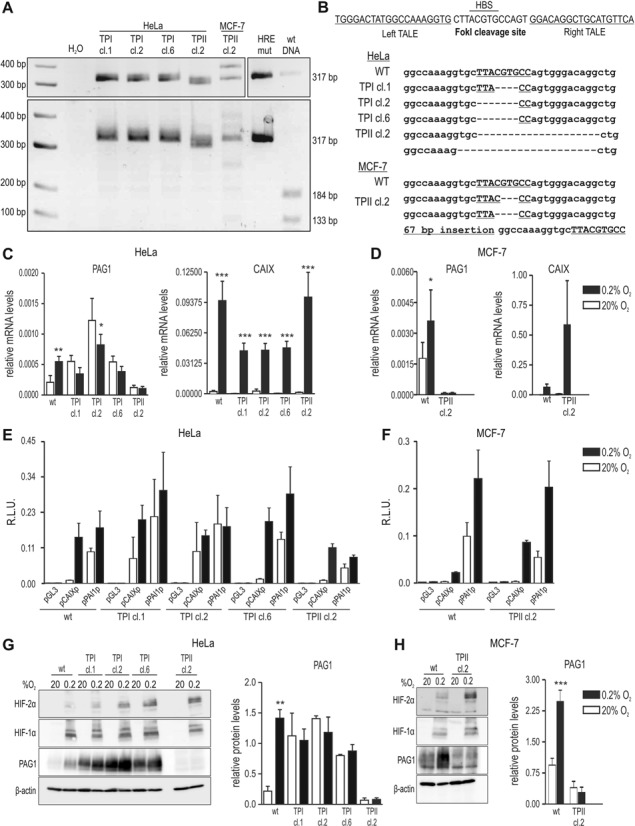
TALEN-mediated destruction of the −82 kb PAG1 HRE. (A) PCR analysis of representative HeLa and MCF-7 clones following co-transfection of two independent TALEN pairs (TPI and TPII) targeting the HBS within the −82 kb PAG1 HRE. A 317 bp fragment encompassing the putative HBS was amplified by PCR and restriction digested with (lower panel) or without BsaAI (upper panel). (B) DNA sequence analysis of the cell clones shown in (A). Dashes indicate deleted bases. Wild-type (wt) and targeted HeLa (C) and MCF-7 (D) clones were exposed to 20% O2 or 0.2% O2 for 24 h, followed by quantification of PAG1 and CAIX mRNA levels. Results of three independent experiments are shown relative to the β-actin control mRNA levels. Statistical analyses were performed with unpaired Student's t-tests (*P < 0.05; **P < 0.01). Targeted HeLa (E) and MCF-7 (F) clones were transiently transfected with the indicated reporter gene vectors. Exposure to hypoxia and determination of reporter gene activity was performed as described in Figure 4A. Proteins from HeLa (G) and MCF-7 (H) cultures treated as above were analysed for HIF-2α, HIF-1α, PAG1 and β-actin levels by immunoblotting (left panels). A single representative immunoblot is shown. Following quantification of three independent immunoblots, PAG1 band intensities were shown relative to the intensities of the β-actin bands (right panels). Results are displayed as mean ± SD of n = 3. Statistical analyses were performed with unpaired Student's t-tests (**P < 0.01; ***P < 0.001).